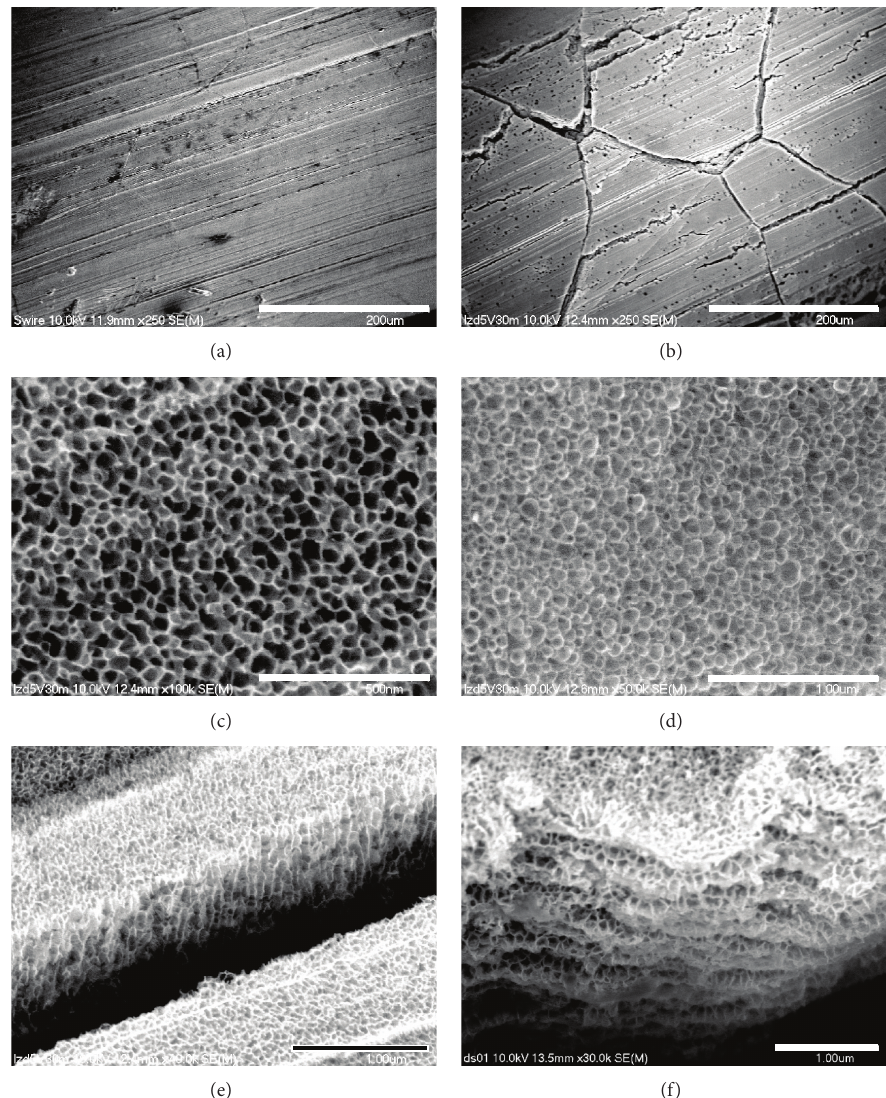
Figure 8: FE-SEMimages of Sn wirebefore (a)and after 30min of anodization in 0.3 M at 5V (b–f).Top (a, b), bottom (c), and cross-sectional (e, f) views of the anodic oxide